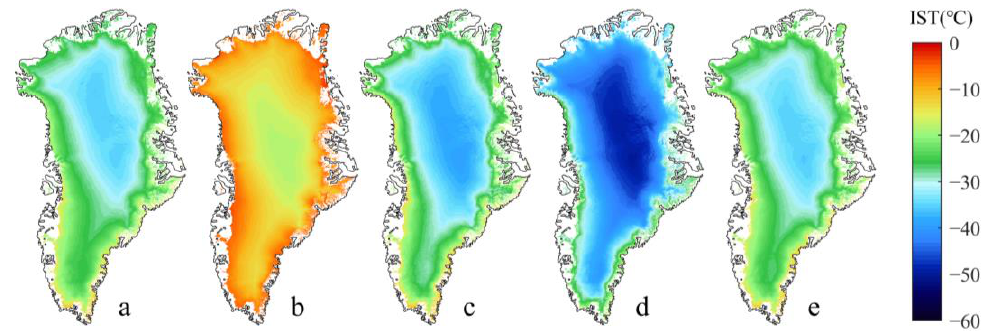
Figure 5. Seasonal MODIS IST over the GrIS in spring ( a ), summer ( b ), autumn ( c ), and winter ( d ) and the mean annual MODIS IST ( e ) from March 2000 to December 2019.